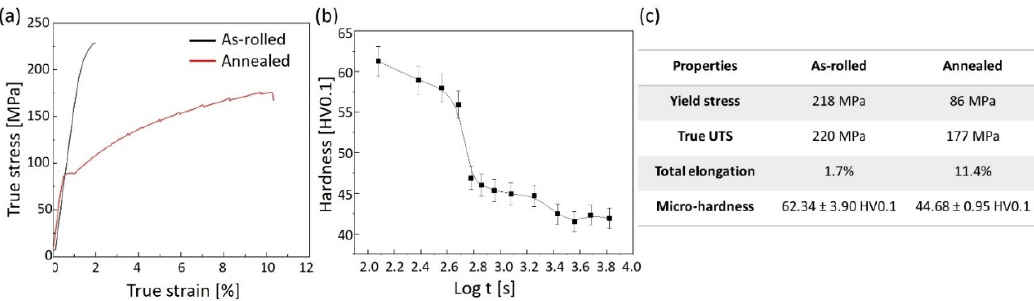
Figure 4. ( a ) True stress vs. true strain curves for tensile deformation of the as-rolled and the annealed LX41 alloy at ambient temperature for a strain rate of 10 − 3 s − 1 , ( b ) change of Vickers hardness over the annealing time t , ( c ) summary of the mechanical properties for LX41 in the as-rolled and annealed conditions. (‘UTS’ stands for ‘ultimate tensile stress’).